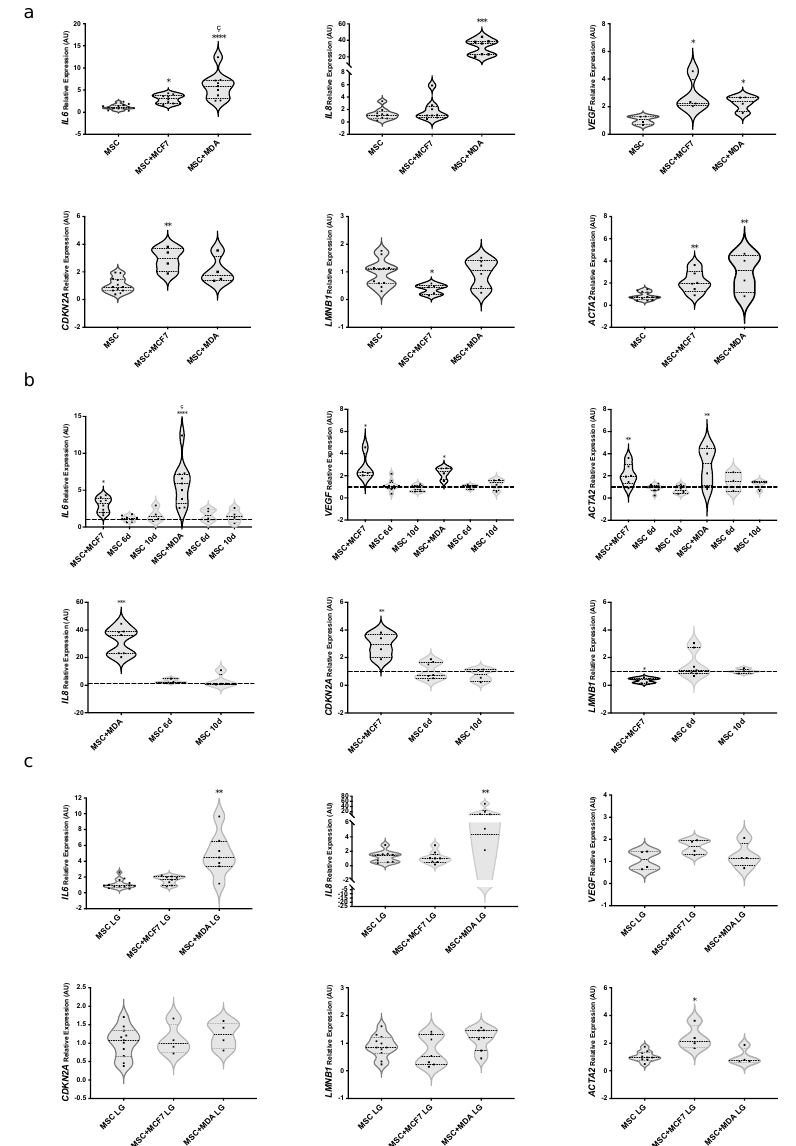
Figure 2. Effect of glucose on MAT - MSCs phenotype in 2D - cultures with BC cells. MAT-MSCs were co-cultured — and not — with MCF7 or MDA-MB231 for 72 h in ( a , b ) standard/high glucose (25 mM glucose; MSC) or ( c ) low glucose concentration (5.5 mM; MSC LG). After 72 h, BC cells were removed while MAT-MSCs were grown for another 3 (MSC 6d) or 7 days (MSC 10d). mRNA expression levels of senescence/fibrosis markers ( IL6, IL8, VEGF, CDKN2A, LMNB1, ACTA2 ) were determined by qPCR (see Section 2 and Supplementary Table S1. Data were normalized on the peptidyl-prolyl cis-trans isomerase A ( PPIA ) gene as per internal standard. Results were represented as: violin plot of 7–9 ( a , c ) or 3–5 ( b ) independent triplicate experiments showing mRNA levels of IL6 , IL8 , VEGF , CDKNA2 , LMNB1 and ACTA2 in MAT-MSCs co-cultured with BC cells as relative expression (2 − ∆∆ Ct ) compared to that in monocultured MAT-MSCs (control cells). In ( b ) monocul- tured cells (control cells) are represented as a dotted line. Data were analyzed using non-parametric Kruskall–Wallis test followed by Dunn’s correction for multiple comparisons. For pairwise com- parisons (MSC + MCF7 vs. MSC + MDA-MB231), Mann–Whitney test was assessed. * denotes statistically significant values compared with monocultured MAT-MSCs (* adjp < 0.05; ** adjp < 0.01; *** adjp < 0.001, **** adjp < 0.0001). ç denotes statistically significant values compared with MSC + MCF7 ( ç adjp <